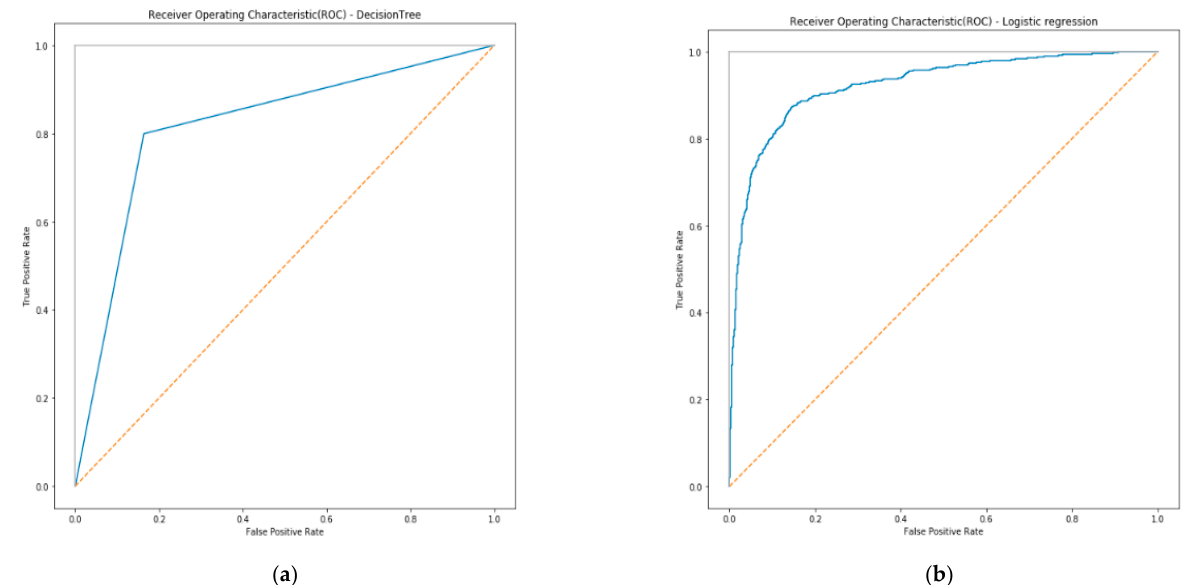
Figure 8. ROC curve analysis using ( a ) Decision Tree and ( b ) Logistic Regression method for eldercare facilities focusing on ‘Beds in Inpatient Facilities’. Source: Developed for the study.